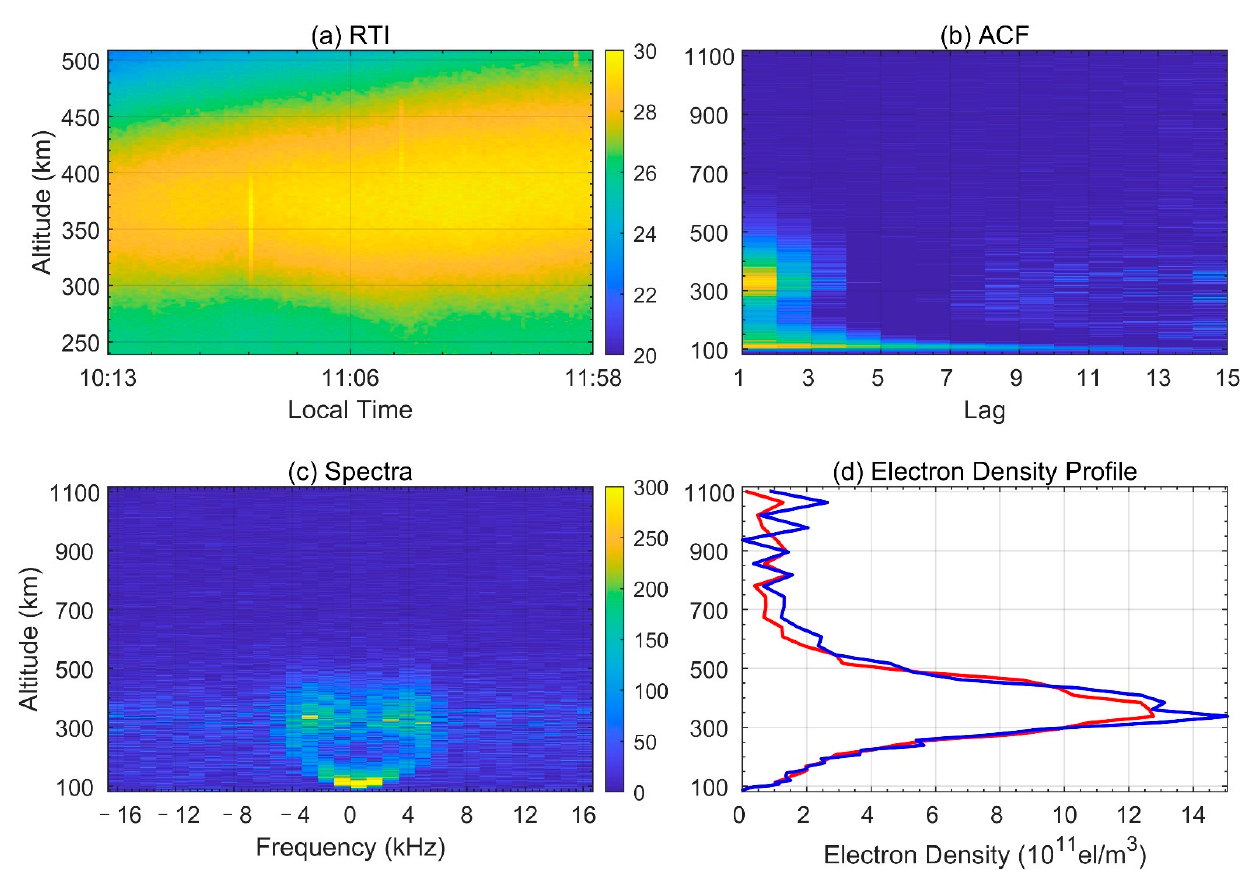
Figure 5. ( a ) Power profile (unit: dB) with weak space object pollution in the ionosphere observed at 10:43:53 on 16 April 2022. ( b ) Autocorrelation function (ACF) with the space object pollution. ( c ) Power spectrum with the space object pollution. ( d ) Electron density profile from the measurement with the space object pollution (blue). The red line is the adjacent electron density profile without space object pollution, which is shown as a reference.